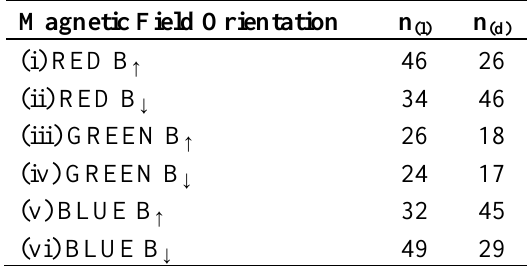
Table 4. Double blind experiment: statistical analysis of the crystallization products of a solution of NaClO (control test) and of the same solution with chiral racemic impurities 3 under an external magnetic field. The three solutions are labeled RED, GREEN and